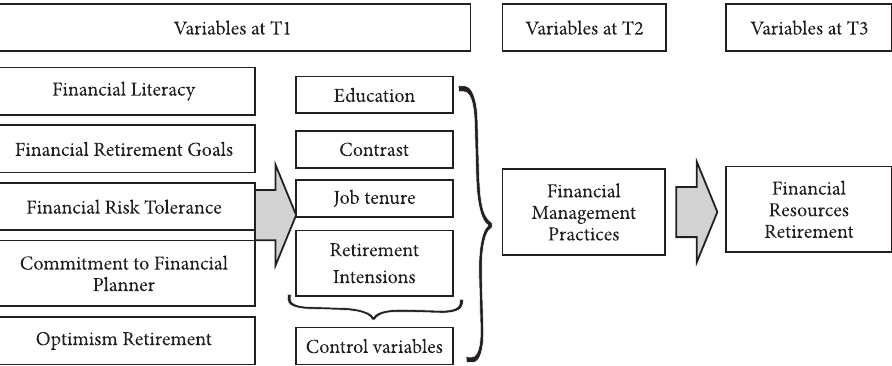
Figure 2. Variables of the